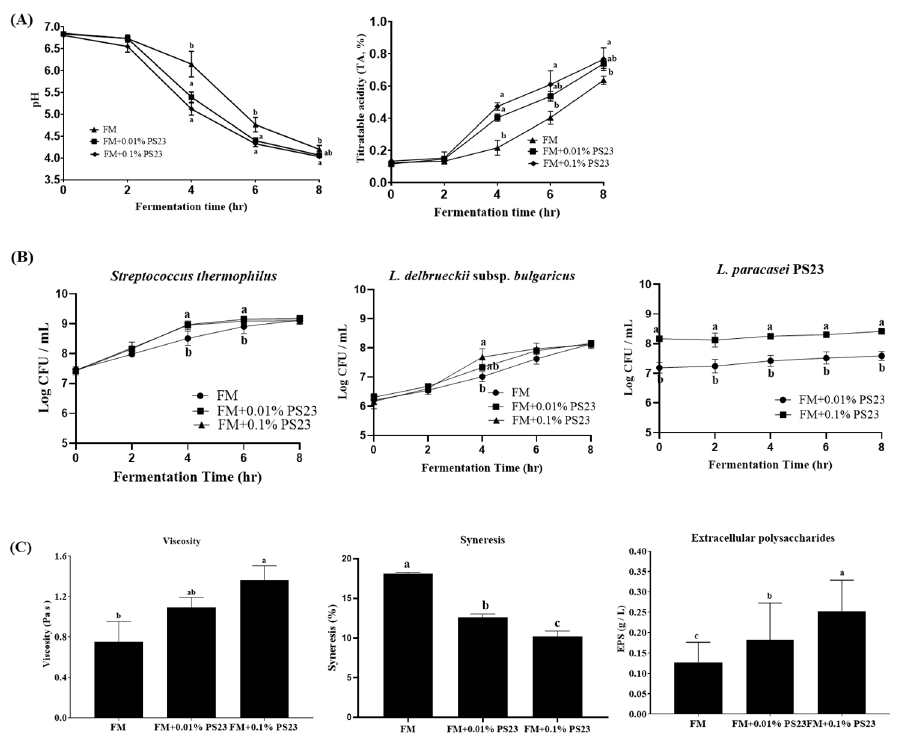
Figure 1. Effect of coculturing PS23 with yogurt culture ( Lactobacillus delbrueckii subsp. bulgaricus and Streptococcus thermophilus ) on ( A ) acidification, ( B ) bacterial counts, and ( C ) rheology of the fermented milk. Data are expressed as mean ± SD. Experiments were performed in three inde-pendent replicates. Statistical analysis was performed using analysis of variance with the Tukey test. Different letters indicate a significant difference ( p < 0.05). PS23: Lactobacillus paracasei PS23, FM: fermented milk with yogurt culture. SD: standard deviation.